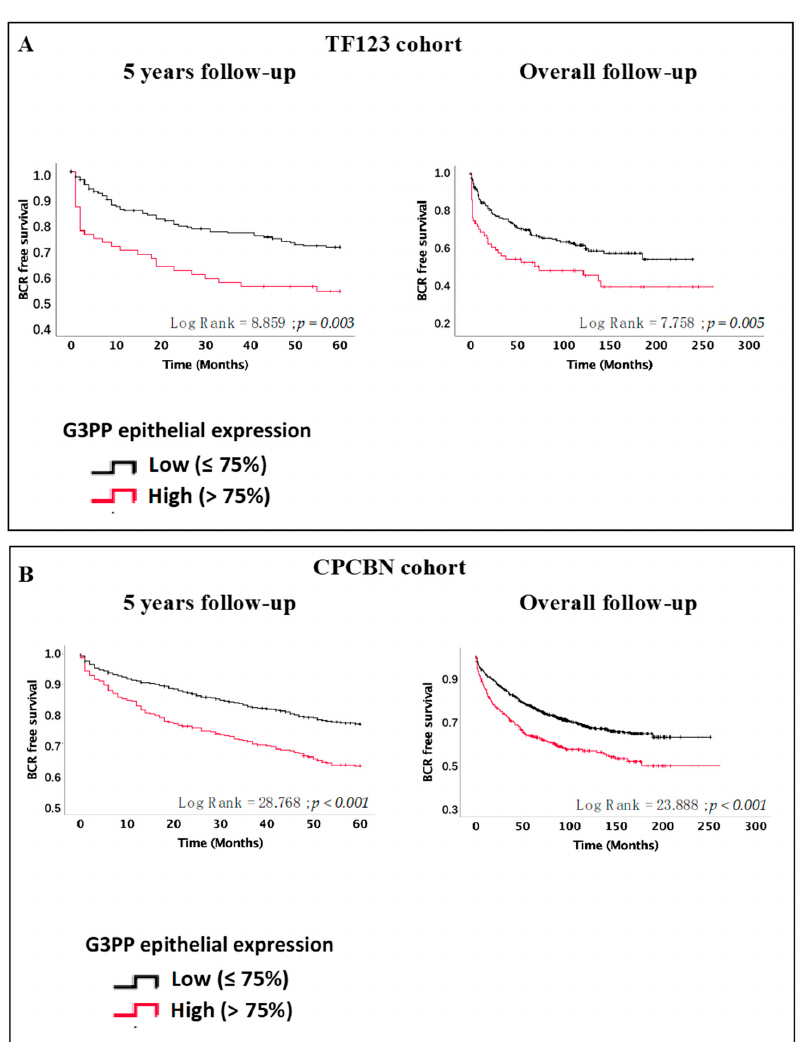
Figure 2. High expression of G3PP is associated with increased risk of biochemical recurrence within 5 years and overall follow-up. Kaplan–Meier biochemical recurrence (BCR)-free survival curves at 5 years and overall for the TF123 ( A ) and CPCBN ( B ) cohort TMAs. Table 2. Univariate and multivariate Cox regression analyses predicting biochemical recurrence (BCR) in the TF123 and CPCBN cohort TMAs after 5-year follow-up. Cox Regression Univariate